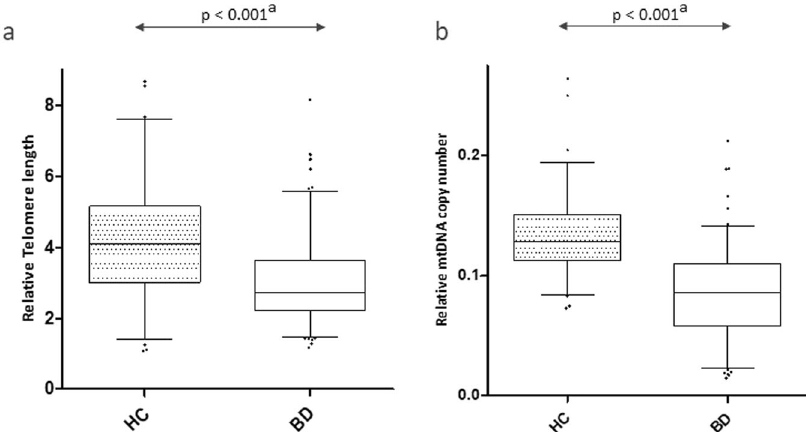
Fig. 1 Telomere length and mtDNA copy number differences between individuals with BD and healthy controls. Box plots representing relative Telomere length ( a ) and relative mtDNA copy number ( b ) in 130 BD and 78 HC. BD bipolar disorder, HC healthy controls. a p values indicate differences between BD and HC after adjustment for age, sex, BMI, tobacco, MADRS, and YMRS (linear regressions).